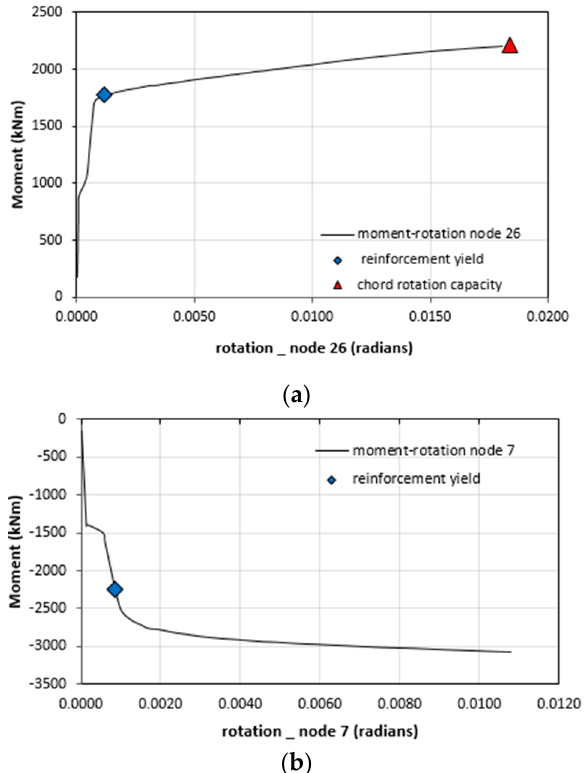
Figure 20. Moment rotation curve for nodes ( a ) 26 and ( b ) 7.